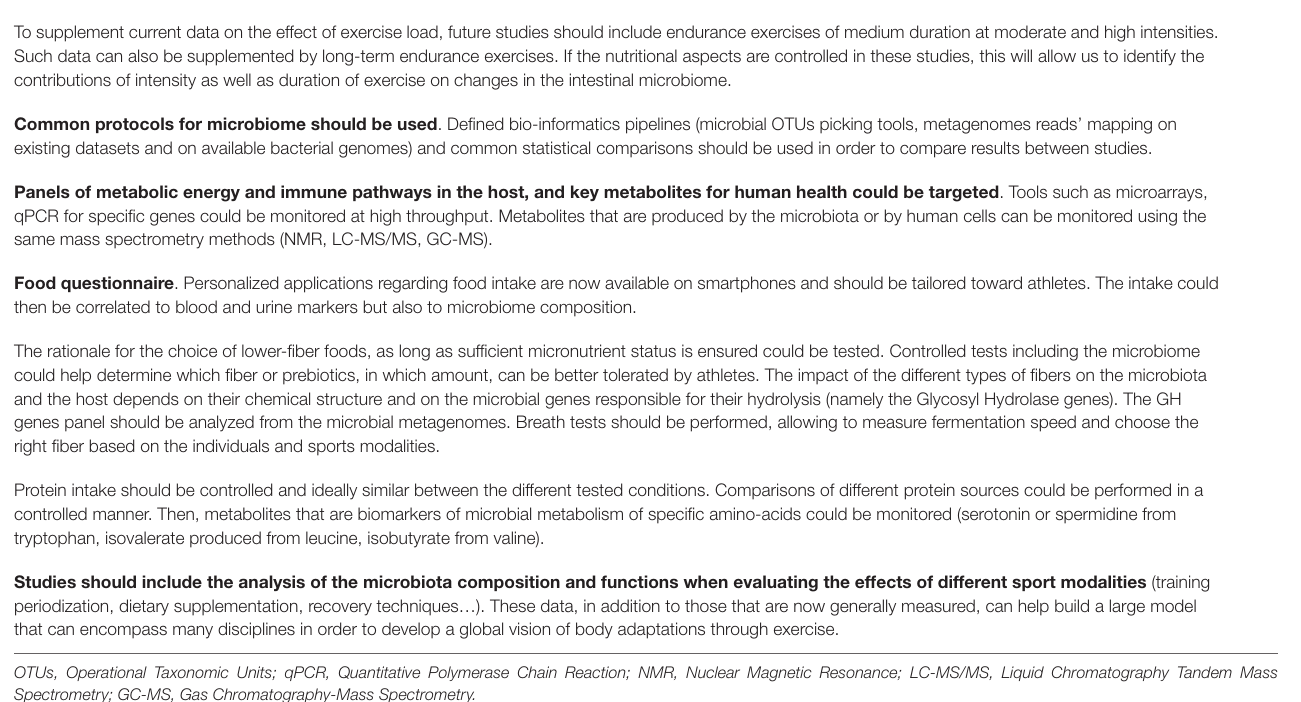
TABLE 3 | Recommendations for more integrated studies in order to understand the interplay between exercise and gut microbiota in recreational athletes and elites. A definition of common research protocols is necessary in order to standardize results and compare studies of different modes of exercise, different environmental conditions, different athletes’ types. Longitudinal studies are needed to understand the short-term effects of a training regimen but also the long-term microbial and physiological adaptations of regular exercise. For example, following athletes over 1 year would inform about switches in microbiota composition and functions during resting and performance training periods. This will then pave the way to personalized training protocols limiting exercise induced dysbiosis. Clinical studies should be performed to evaluate the benefit of exercise on gut microbiota composition and function, as well as on health, in individuals at risk of specific diseases (e.g., diabetes, overweigh, cardiometabolic disorders, IBD, etc.). Animal models would validate the role of such microbiota exercise-induced alterations on health.